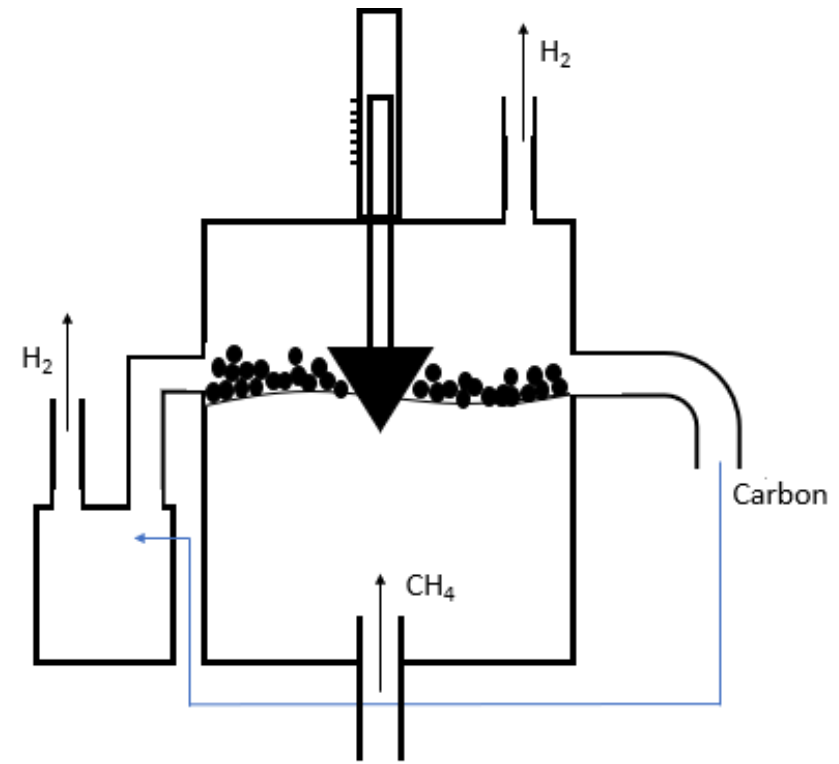
Figure 4. Reactor design for periodic carbon separation in a continuous molten media methane cracking process (adapted from Ref. [32] with Elsevier permission). Molten media, in general, diminish the activation energy of the cracking reaction, similar to solid catalysts. The activation energies of the main molten media used for methane cracking are gathered and compared with conventional catalysts in Table 4. It can be seen that the activation energies of molten media are comparable with those of carbonaceous